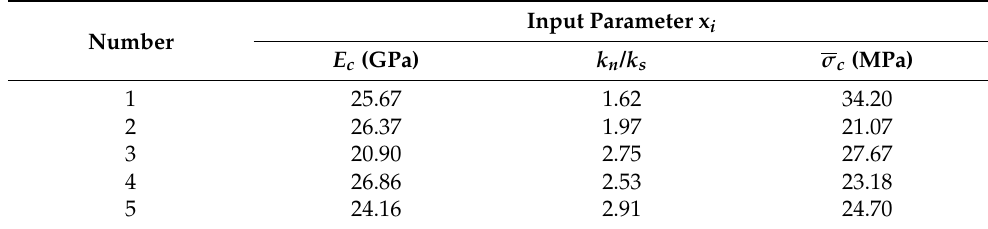
Table 4. 15 random samples for verifying the SVR